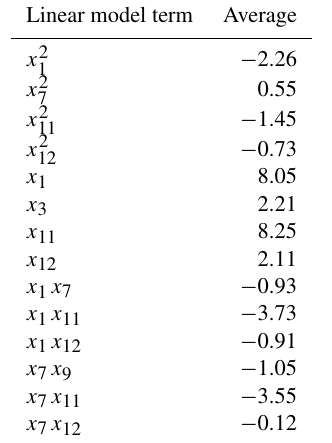
Table 5. Average of the expected values of selected β coefficients across all regions. Any term not present has small coefficients in all regions or was inactive in all regions. Note that the sensitivity to x 11 is overstated because it was active only in a few regions, and one of those regions exhibited unusual